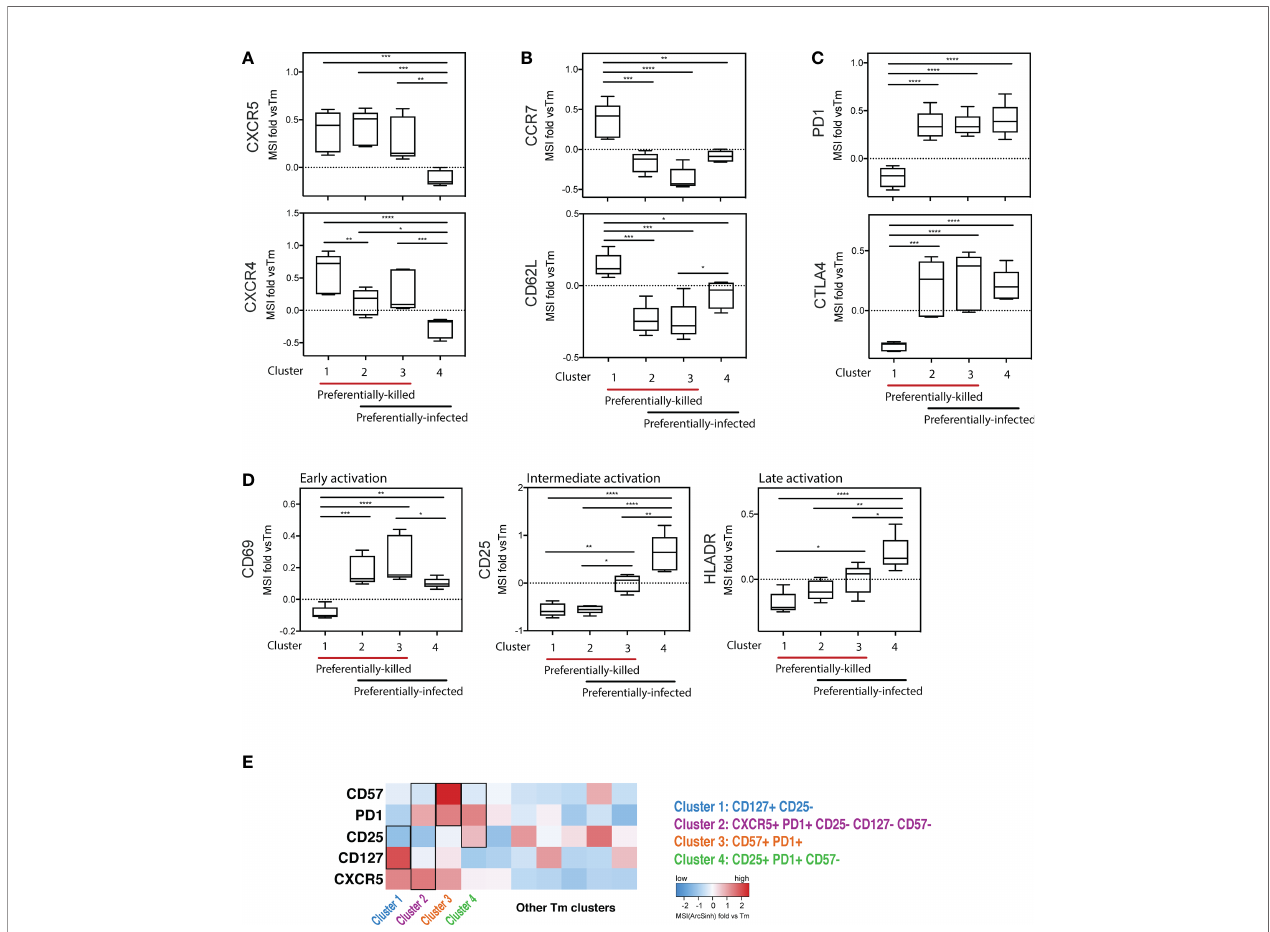
FIGURE 5 | Deep phenotyping of the preferentially-killed versus preferentially-infected CD4 Tm subsets. (A – D) Expression levels of selected cell markers in clusters 1-4 (identi fi ed in Figure 4 ) relative to the CD4 Tm population (MSI fold vs Tm). For each marker, the mean expression intensity (MSI) of the cluster is compared to the MSI of the Tm population, according to the following equation: (MSI Cluster / MSI Tm ) -1. If this value is > 0, the cluster cells expressed a higher level of the selected cell marker on average than did the total Tm cells. On the x-axes, clusters 1-4 were grouped into 2 categories including preferentially-killed (red line) and preferentially-infected (black line). The plots combine data from 6 donors. *p ≤ 0.05; **p ≤ 0.01; ***p ≤ 0.001; ****p ≤ 0.0001; no label: not signi fi cant, p > 0.05. Signi fi cance was measured by one- way ANOVA with repeated measurements followed by post-hoc tests for multiple comparisons correction. (n = total paired-wise comparisons). (E) Heatmap of the 5 cell markers that can be used to distinguish cells belonging to clusters 1-4 from other Tm cells. The marker combinations corresponding to the 4 clusters is listed on the right. All MSI values used in Figure 5 were arcsinh